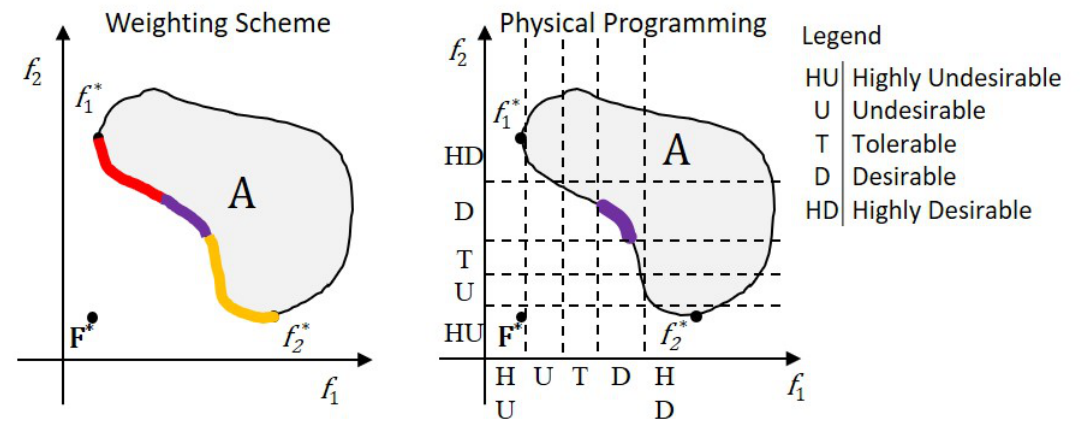
Figure 2: Pareto front for WS and